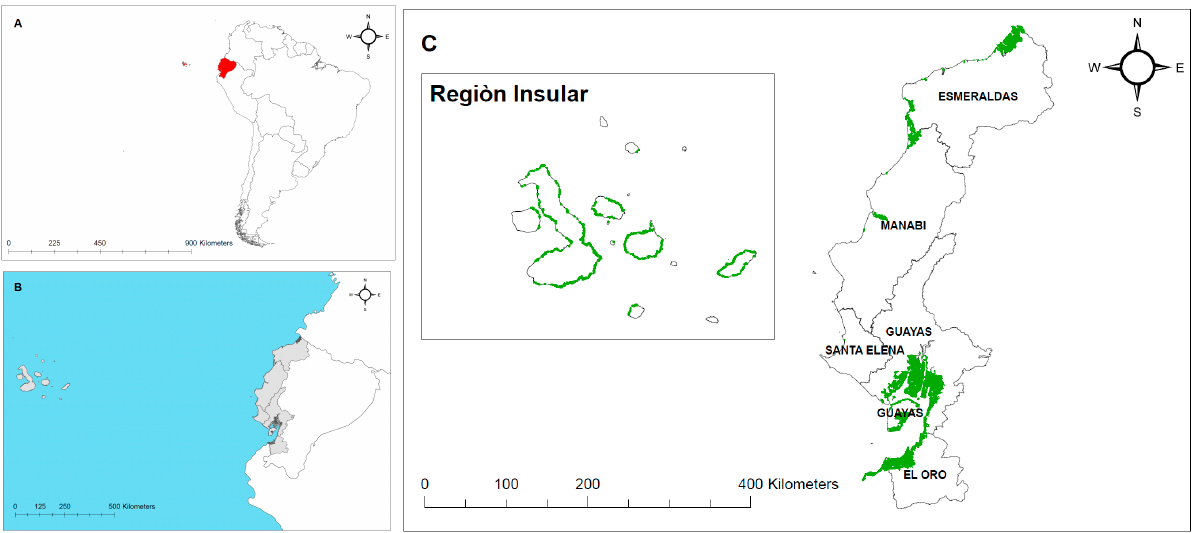
Figure 1. Study area: ( A ) Geographical location of Ecuador; ( B ) insular and coastal region of Ecuador; ( C ) provinces with mangrove